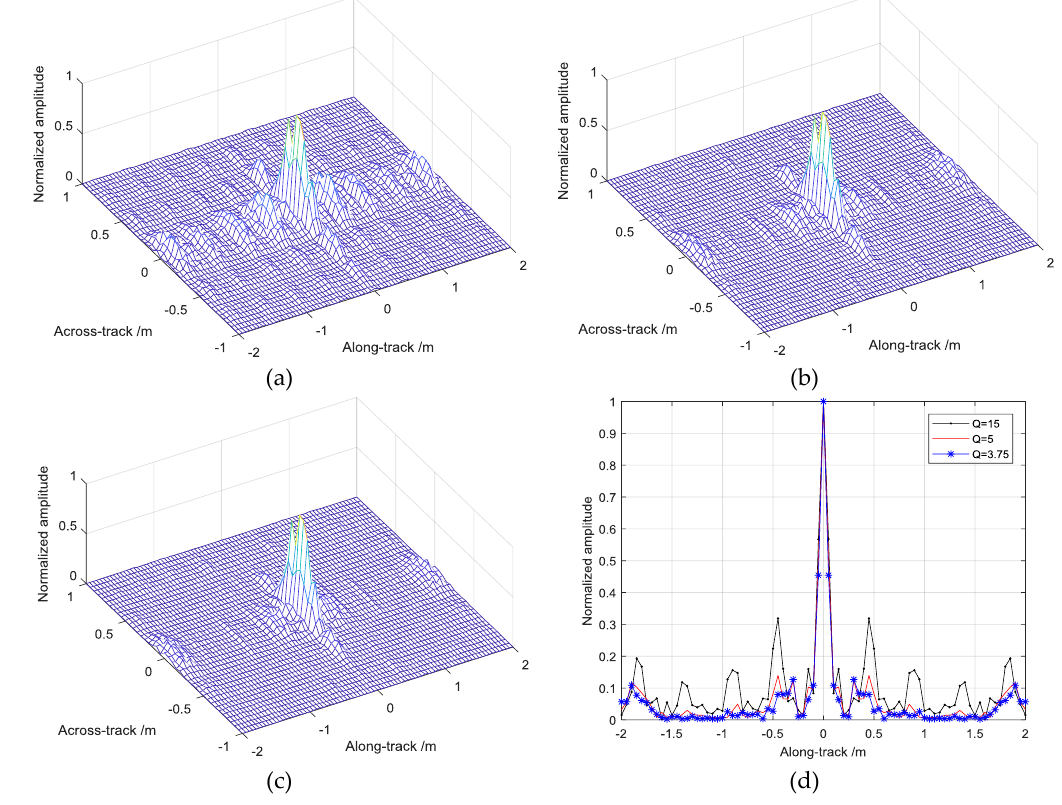
Figure 5. Side lobe comparison between signal bandwidth situations: ( a ) MBSAS output 2D sliced when Q = 15; ( b ) when Q = 5; ( c ) when Q = 3.75; ( d ) MBSAS output sliced on the along-track.